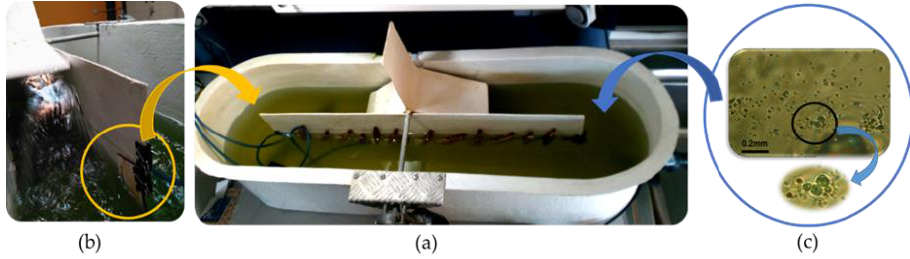
Figure 1. Schematic description of the coating method: ( a ) preparation of metal-nanoparticles (NPs) doped PVA/GA coatings; ( b ) NP deposition by spin coating and ( c ) example of the appearance of the coated substrate.